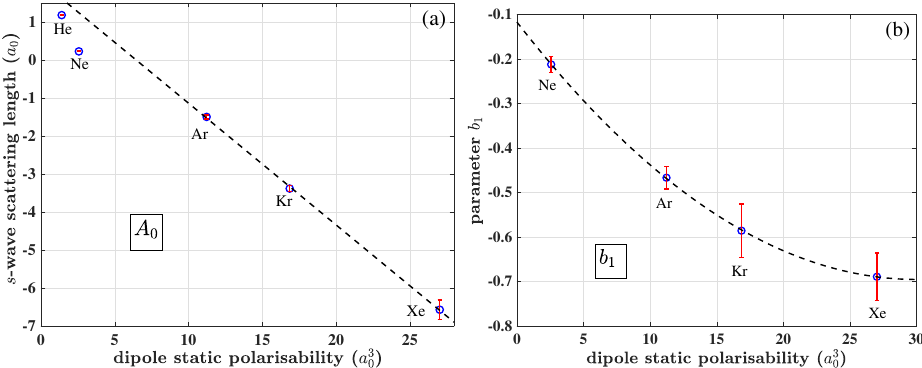
Figure 8. ( a ) MERT − derived s − wave scattering lengths and ( b ) parameter b 1 for rare gases plotted versus static dipole polarizability. The presented results are the mean values of MCMC − MERT analysis of different experimental cross − section datasets. The standard deviations of mean values are given to demonstrate the uncertainties in the determination of coefficients. The dashed lines are sketched as the guide to eyes to show general tendencies in A 0 ( α ) and b 1 ( α ) dependencies.